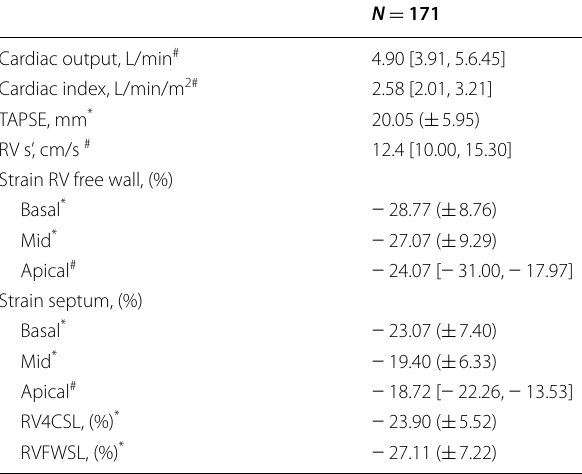
Table 3 Echocardiography variables